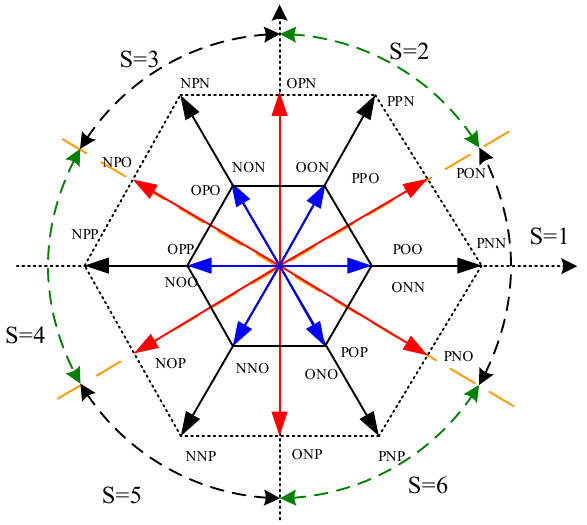
Figure 4. Sectors for the proposed three-level converter with the simplified PWM.